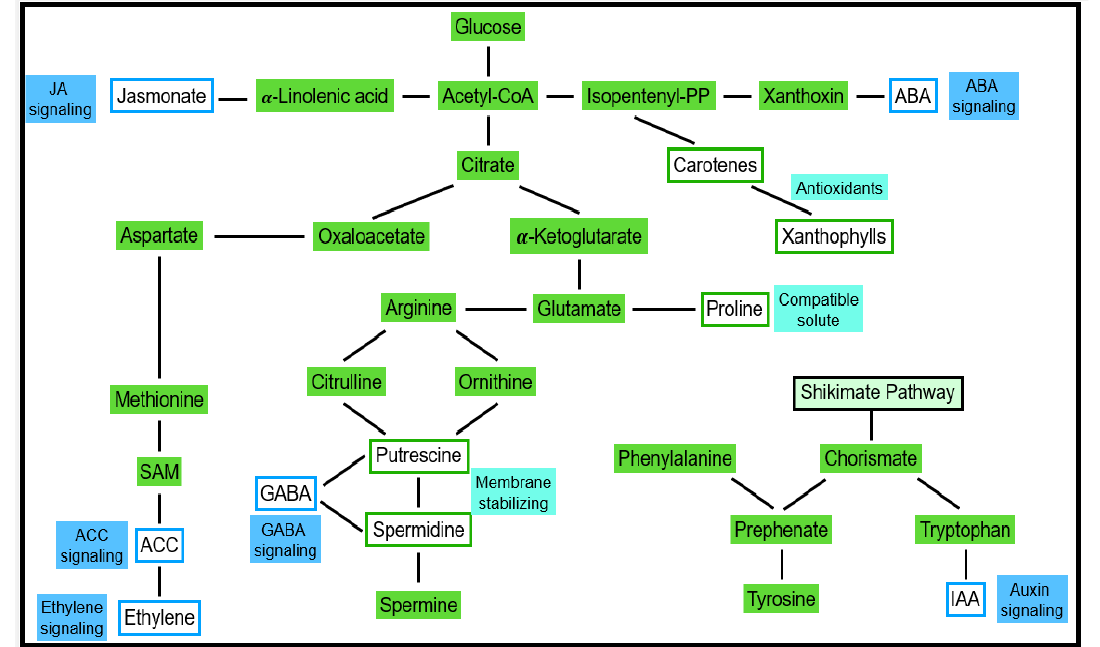
Figure 5. The synthesis of compatible compounds and signaling molecules integrating into plant metabolism. Depending on the respective genetic potential, plants differ in the expression of metabolic pathways. Moreover, these preferences may vary during a plant’s life cycle. This has consequences for the preferences to produce individual compounds such as compatible solutes, hormones, and other signaling molecules. Levels of these molecules depend on both availabilities of substrates (precursors) and the activities of enzymes involved in biosynthesis.